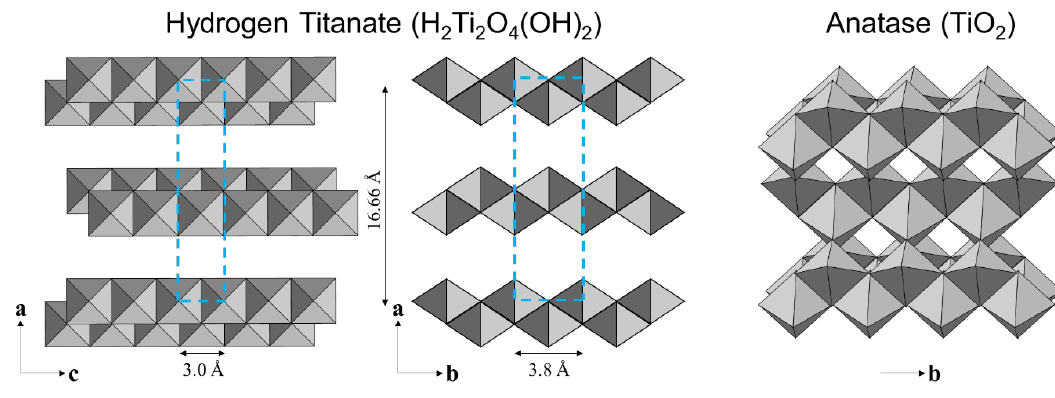
Figure 9. Hypothetical schematic view of a hydrogen titanate crystal.